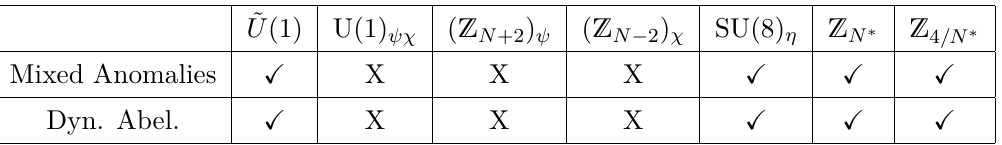
Table 3 . Dynamical Abelianization postulate of the present work is confronted with the implica- tions of the mixed anomalies. X for a conserved symmetry, X for a broken symmetry. The discrete Z symmetry is defined in (3.19), or in (4.27)–(4.30). Z N ∗